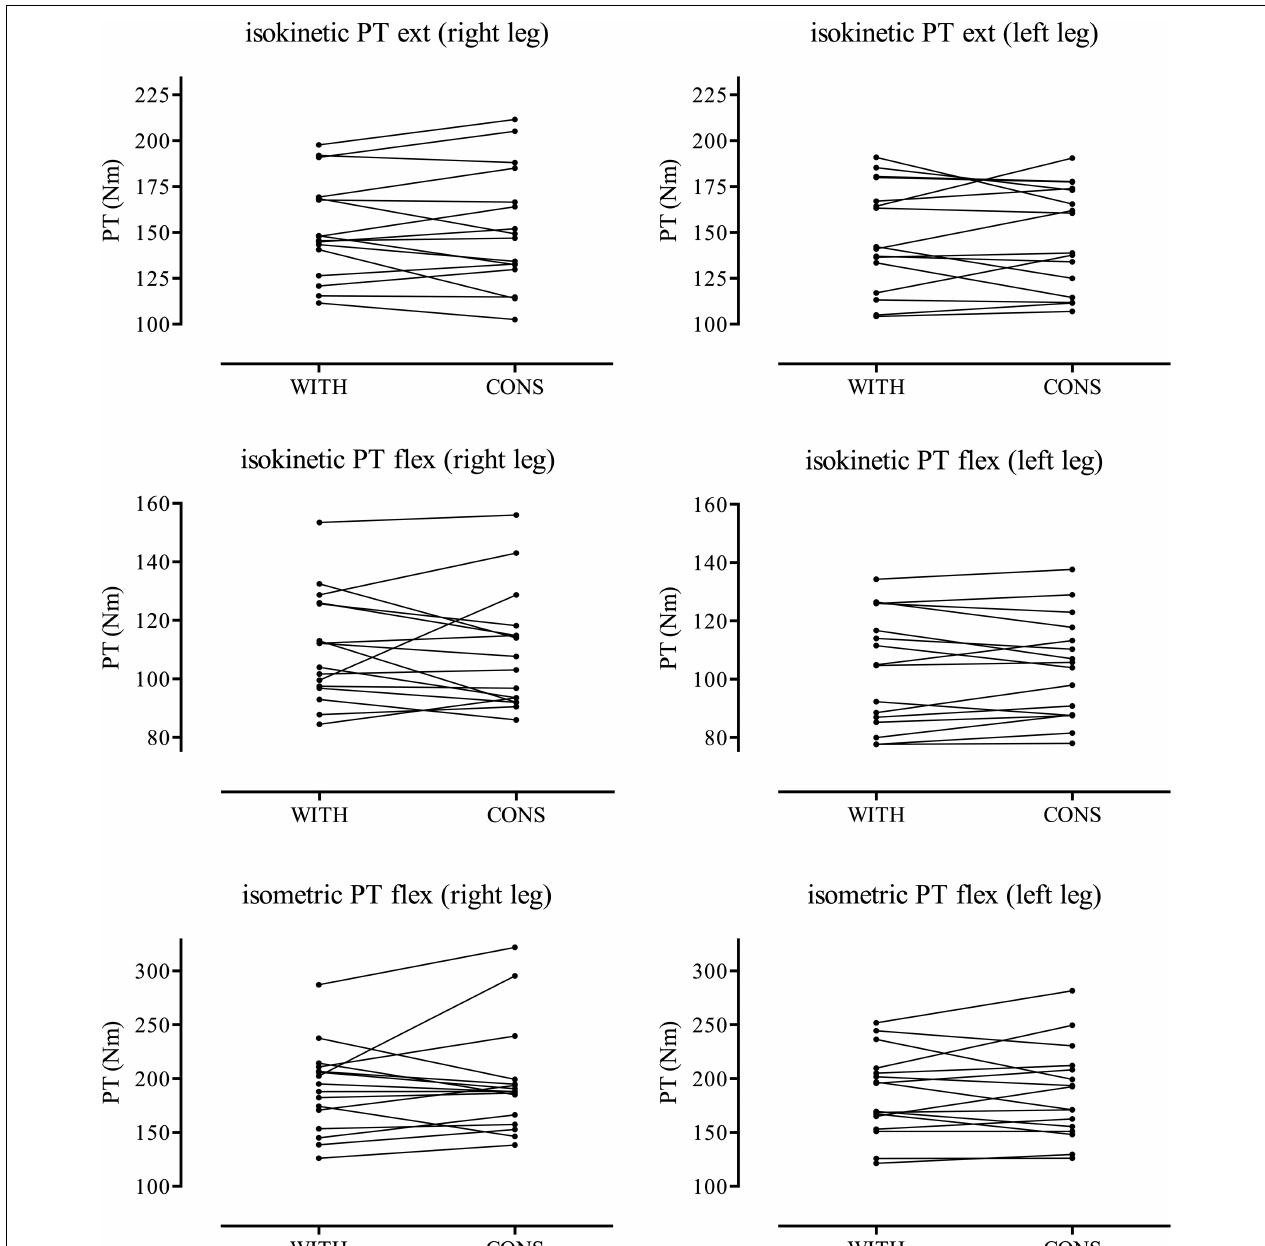
FIGURE 1 | Individual changes of PT for extension and flexion for right and left legs during withdrawal phase (WITH) and consumption phase (CONS).